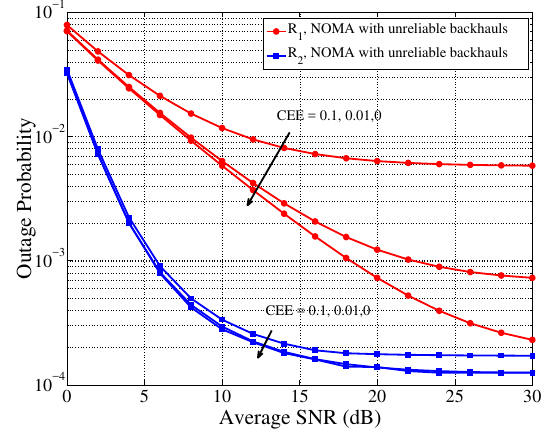
Figure 4. Outage probability of NOMA under unreliable backhauls and fronthaul channel uncertainty with opportunistic SS based on nearer receiver, R . Simulation parameters are as 2 follows: the number of transmitters, K = 3 , the channel estimation error, CEE = 0.1,0.01,0, the power allocation parameters, a 1 = 0 . 8 , a 2 = 0 . 2 , the target SINRs, γ th = 0.1 dB, the backhaul reliability, p , m parameter of Nakagami- m k = 0 . 96 , 0 . 95 , 0 . 94 fading for the k -th transmitter, m k = 1 , 2 ,